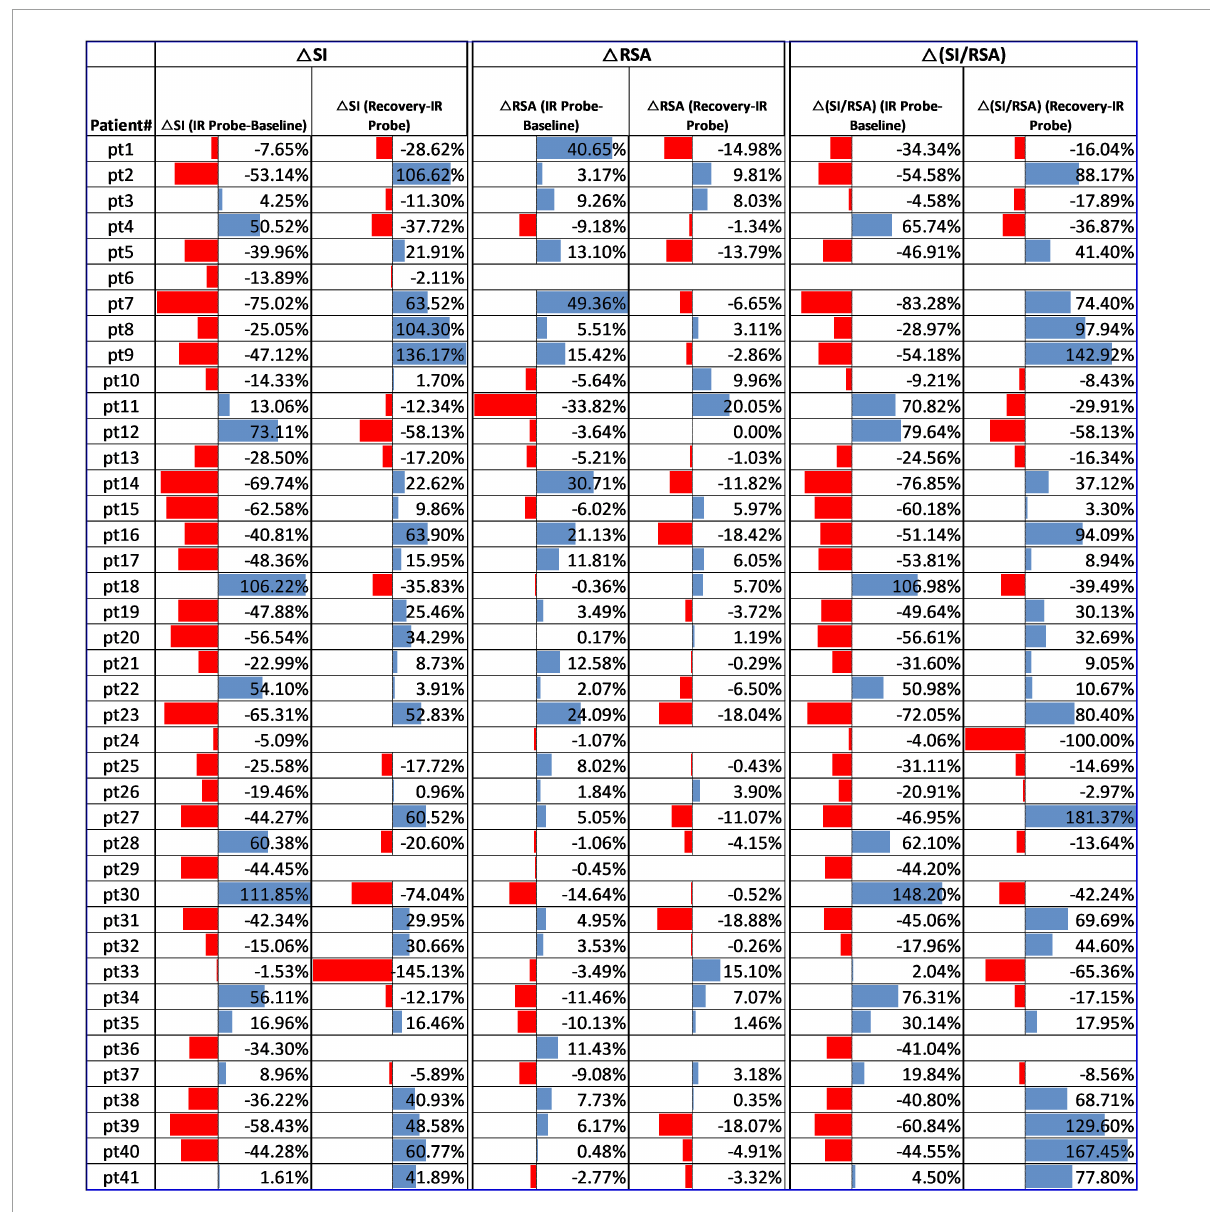
FIGURE3 Change in RSA, SI, and SI/RSA due to laser probe stimulation and recovery in all 41